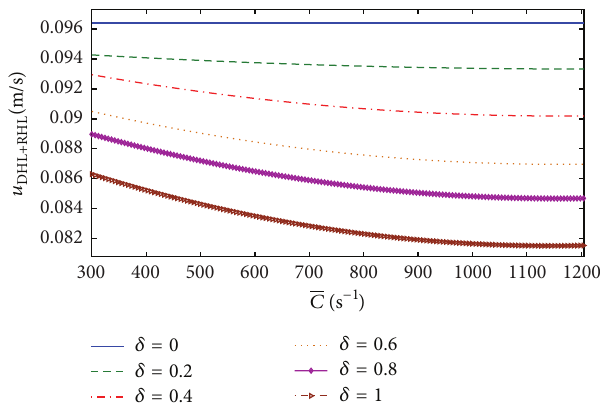
Figure 6: Influence of vaporization coefficient on spray flame propagation velocity at critical values of volumetric/radiative heat loss parameter for different initial droplet loads, monosectional